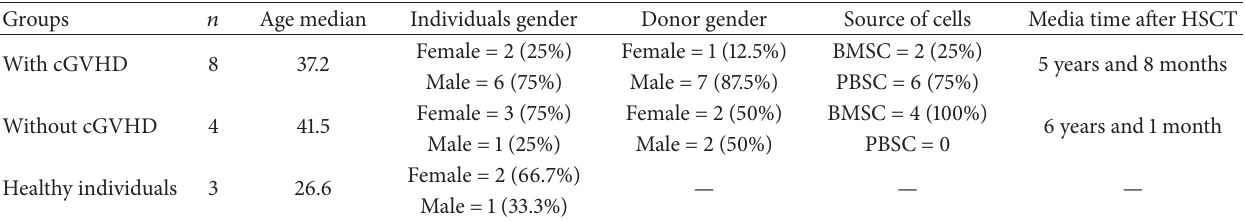
Table 4: Clinical characteristics of recipients with cGVHD ( 𝑛 = 8 ), recipients without cGVHD ( 𝑛 = 4 ), and healthy individuals ( 𝑛 = 3 ) included in the immunophenotypic